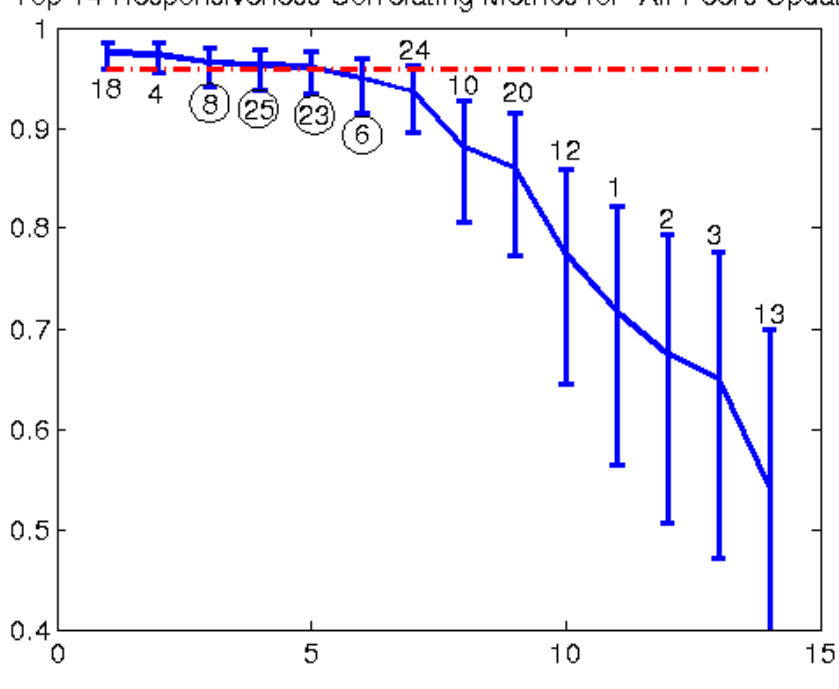
Figure 7. Pearson correlation with responsiveness top 14 AESOP metrics all peers and no models